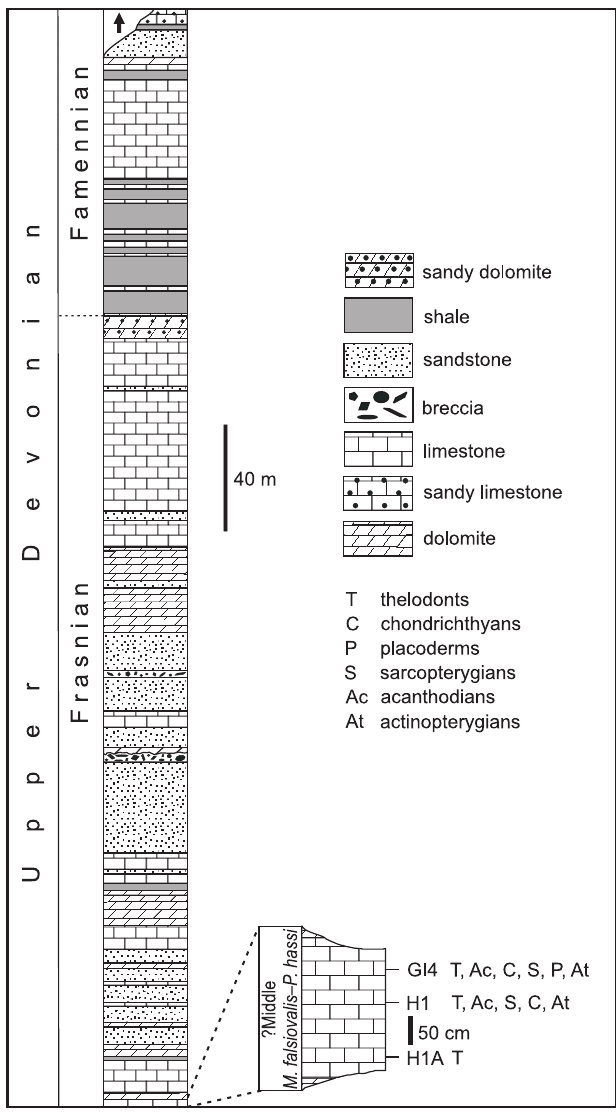
Holotype : AEU 301, flank scale (Fig. 3A). Type locality : Chahriseh section, Kaftari Mt., central Iran. Type horizon : GI4, the middle Mesotaxis falsiovalis to Palmatolepis hassi conodont zones.